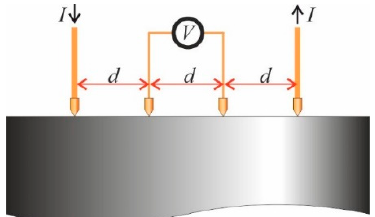
Figure 4. Scheme of the four-point probes used for the determination of the electrical resistivity. The four electrodes are connected to a Kelvin bridge that supplies the ratio V / I (that is, R ) from which the resistivity can be calculated.